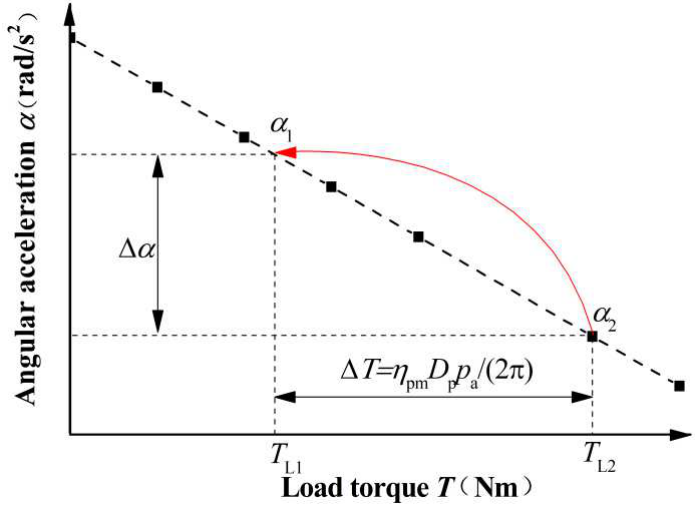
Figure 2. Working principle of the assisted starting concept. When the variable frequency motor is started with a hydraulic pump, the high-pressure oil in the accumulator enters oil port B of the hydraulic pump, and port A outputs high-pressure oil. Therefore, the hydraulic pump can be abstracted as a hydraulic motor and a hydraulic pump with both displacements D P . The torque of the pump can be expressed as Equation (4): where D p is the displacement of the pump, p p is the pump output pressure, p a is the pump input pressure, and η pm is the mechanical efficiencies of the pump. According to Equations (1)–(4), the relationship between the angular acceleration and load torque of the motor is given in Figure 3.